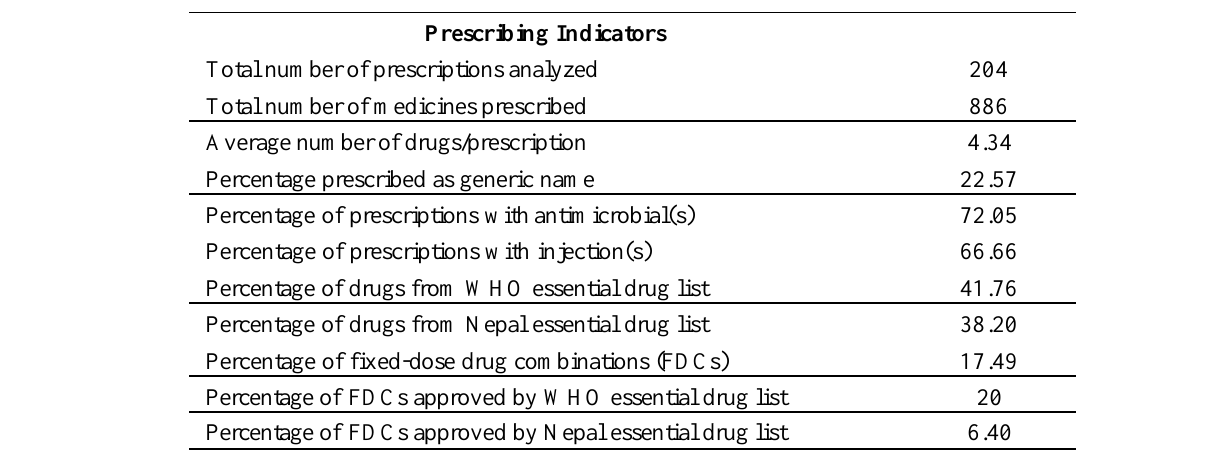
Table I : Analysis of Prescriptions from College of Medical Sciences, Bharatpur, Nepal Prescribing